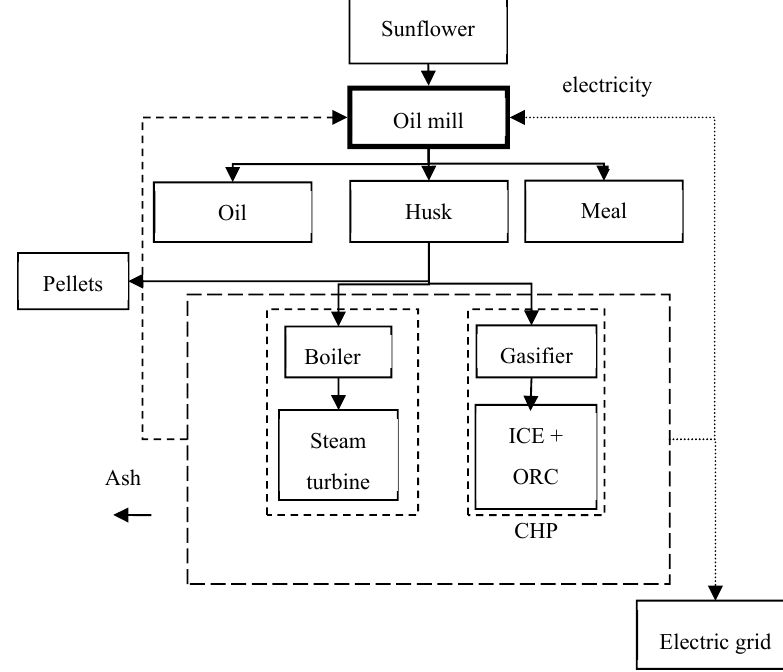
Figure 11. Energy supply scheme of Sunflower Seed Oil Mill (developed by author).